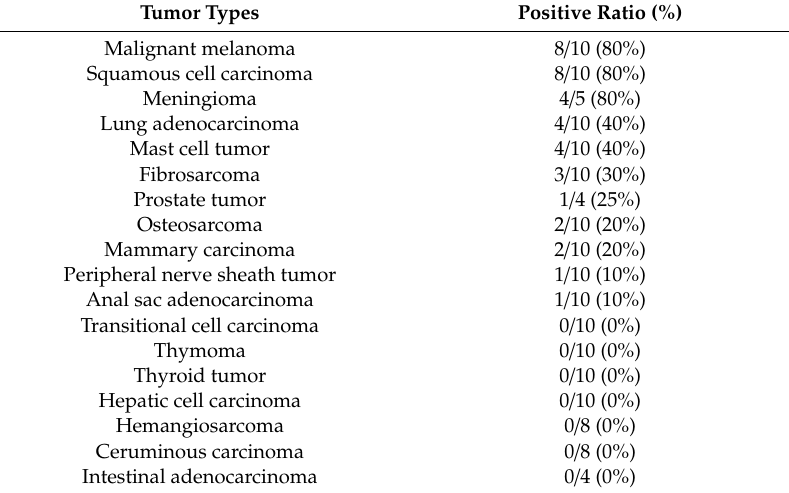
Table 1. Evaluation of dog podoplanin (dPDPN) expression in canine tumor